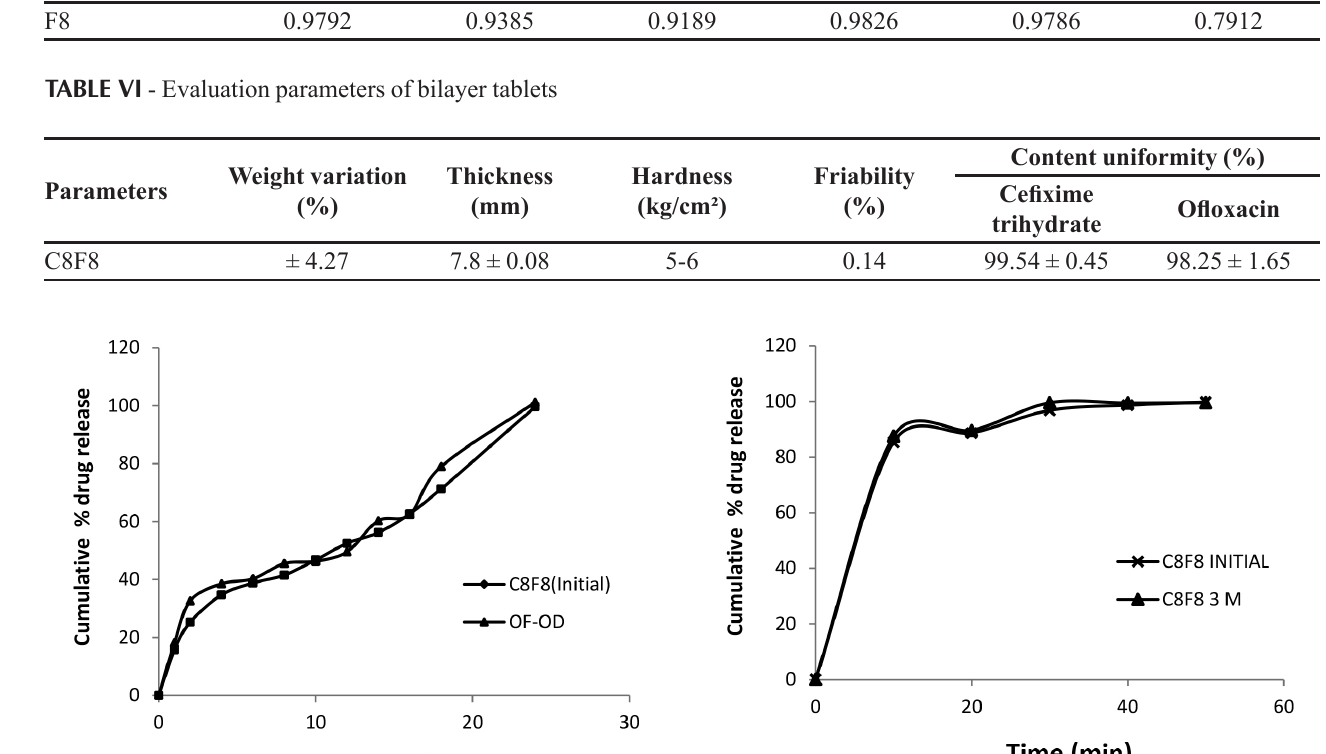
TABLE V - Drug release models for optimized batch Formulation